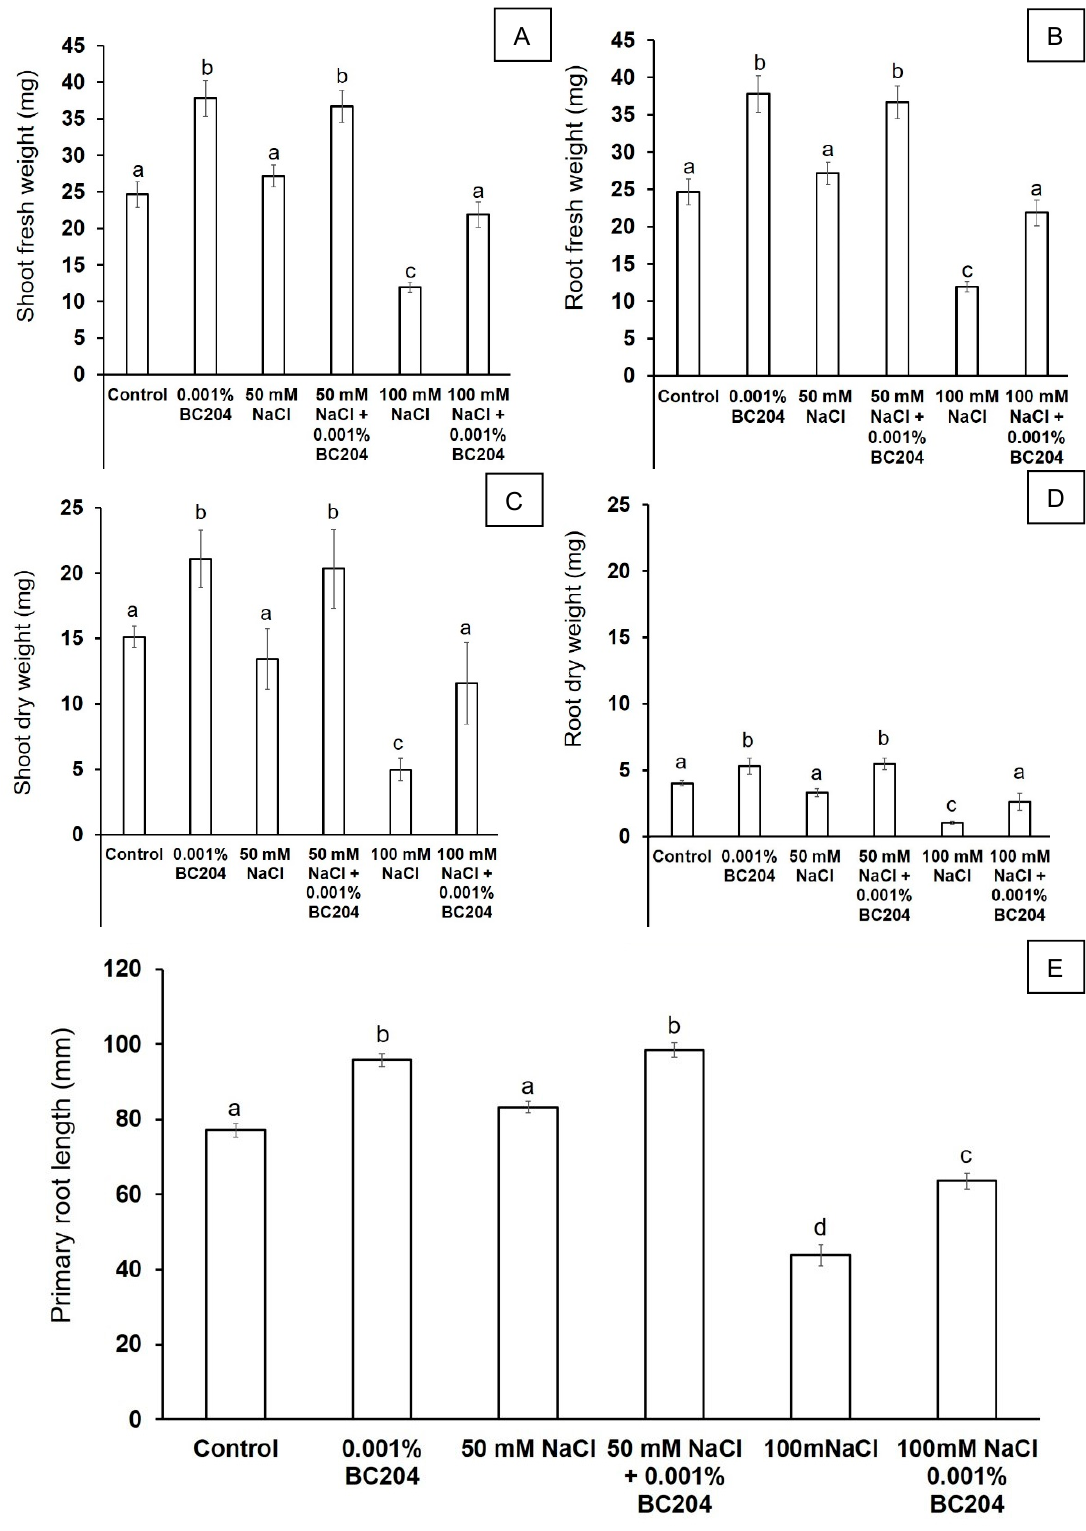
Figure 4. Shoot ( A ) and root ( B ) fresh mass, shoot ( C ) and root ( D ) dry mass and primary root length ( E ) of in vitro grown Arabidopsis thaliana seedlings treated with BC204 and NaCl. Bars for tissue fresh weight and primary root length represent the mean of 20 replicates ( n = 20) ± standard error. Bars for tissue dry weight represent the mean of three pooled samples of 10 replicates ( n = 3). Di ff erent letters indicate values that were determined by one-way ANOVA with Fisher’s LSD post-hoc test to be significantly di ff erent ( p < 0.05) from the